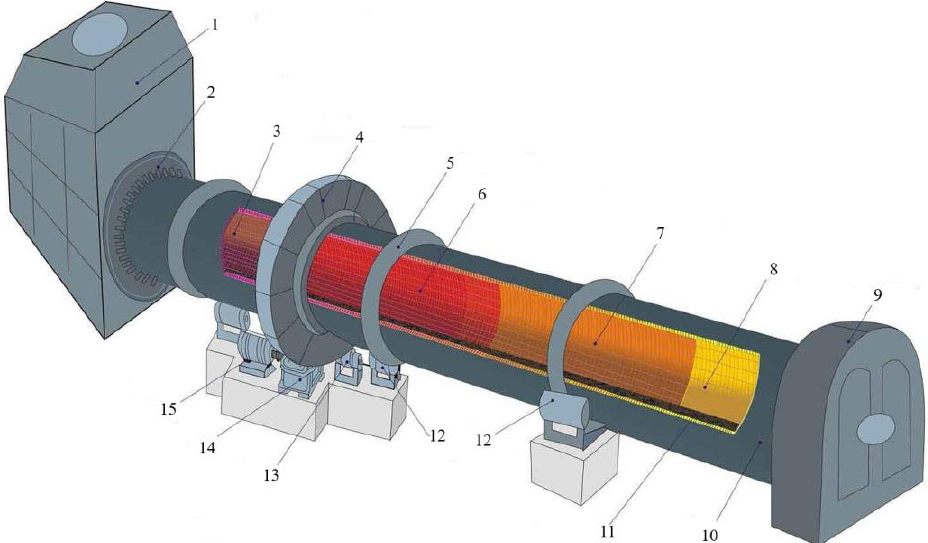
Figure 1. Determination of critical areas for the study of the total efficiency of a rotary kiln [25]: 1—kiln end chamber, 2—kiln end seal, 3—preheating zone, 4—big gear ring, 5—belt of wheel, 6—transition zone, 7—burning zone, 8—cooling zone, 9—cover of kin head, 10—barrel, 11—clinker, 12—riding wheel, 13—small gear, 14—reducer, 15—motor.